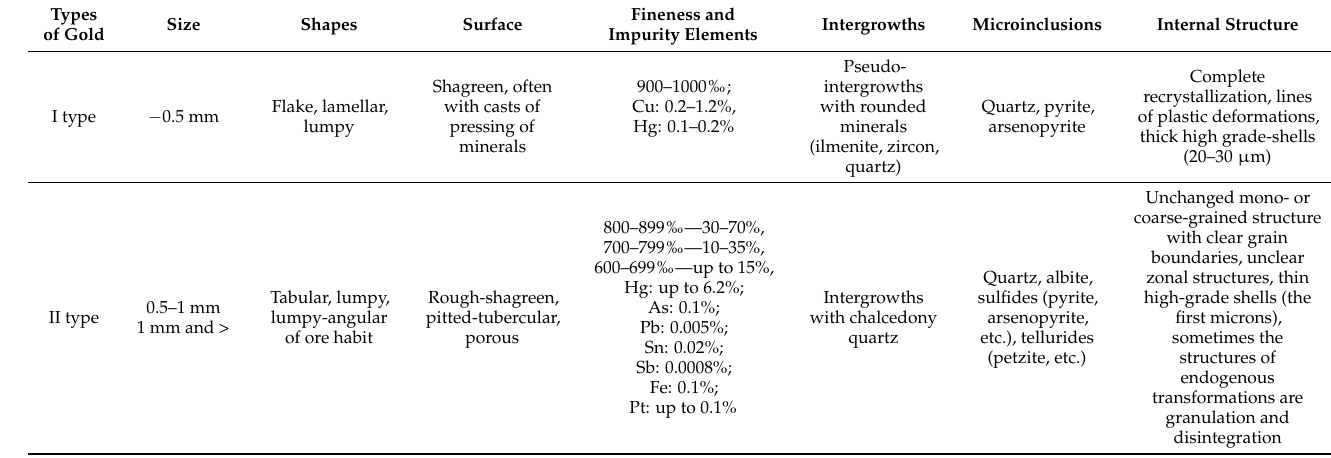
Table 1. Typomorphic features of two types of placer gold from the east of the Siberian